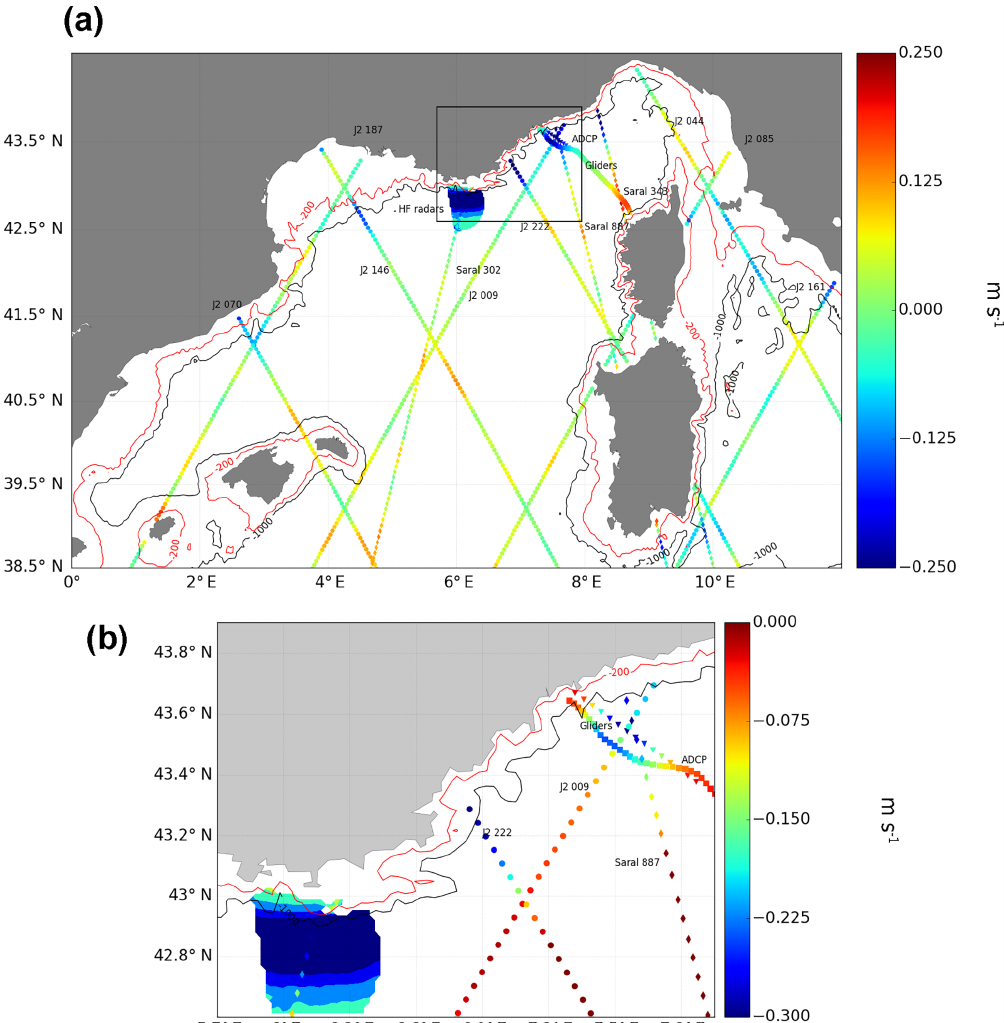
Figure 2. (a) Map of the mean current values derived from ADCP, glider, HF radar and altimetry data over the period March 2013– October 2014. (b) Zoomed-in view of the northern Ligurian Sea (black rectangle indicated in panel a ); 200m (red line) and 1000m (black line) isobaths are also shown. Current values are positive (negative) to the right (left) of the ship, glider or satellite